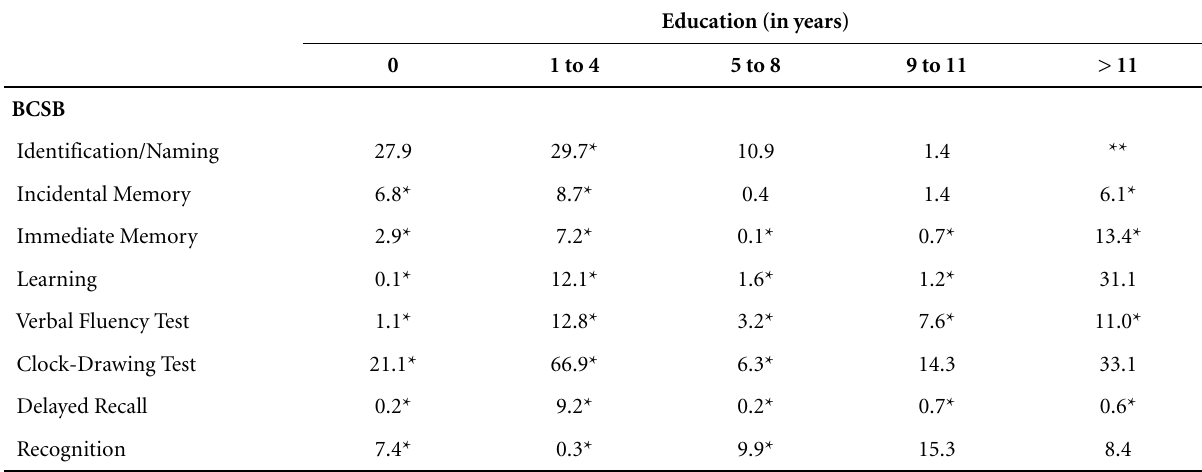
Table 2. Intergroup difference (F and significance level) related to